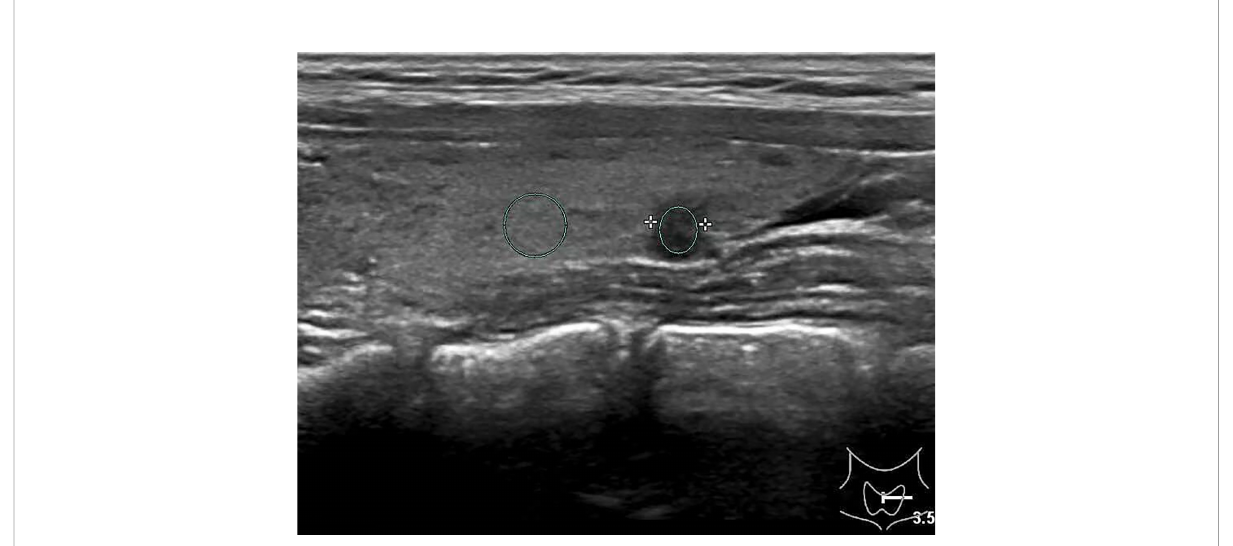
FIGURE 2 Female patient, 32 years old, 8-year case history of a thyroid nodule, pathology con fi rmed as PTMC with HT. TPO-Ab = 90.2 kU/L, TG-Ab>500 kU/L, UGSR = 43.18/95.61 = 0.4516 (medical center